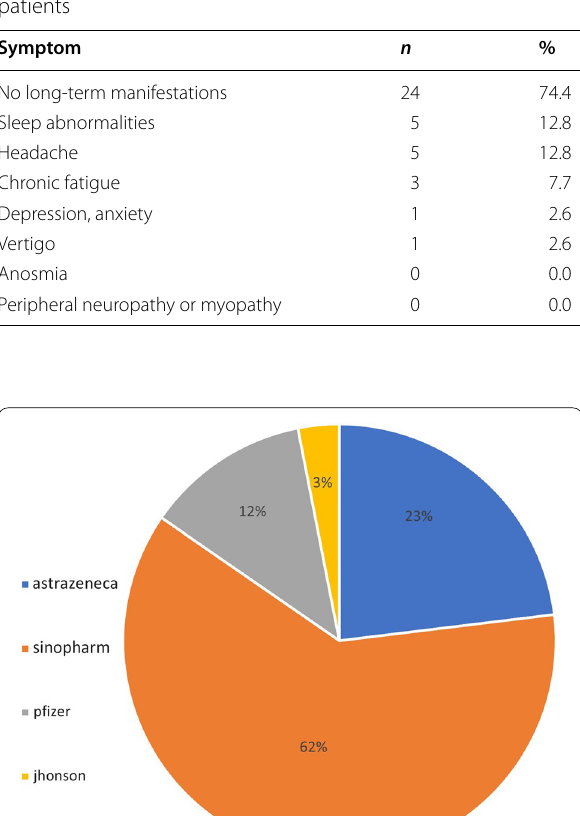
patients (30%) got their information from asking their Table 2 Long-term manifestations of COVID-19 reported by MS